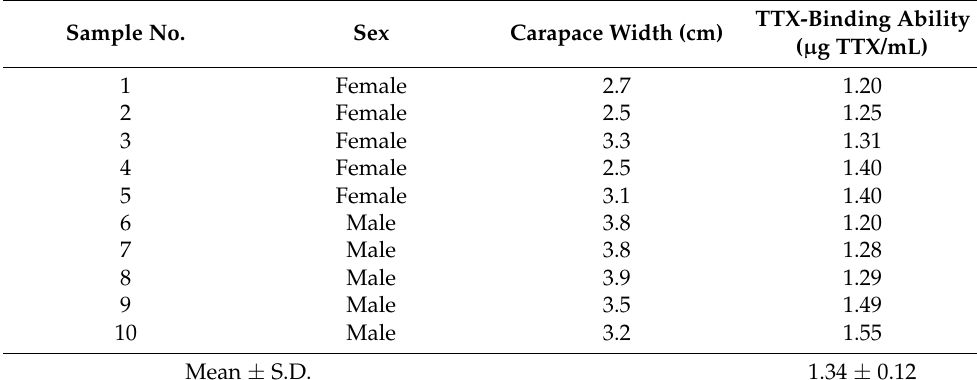
Table 1. TTX-binding activity of the shore crab hemolymph sample. Sample